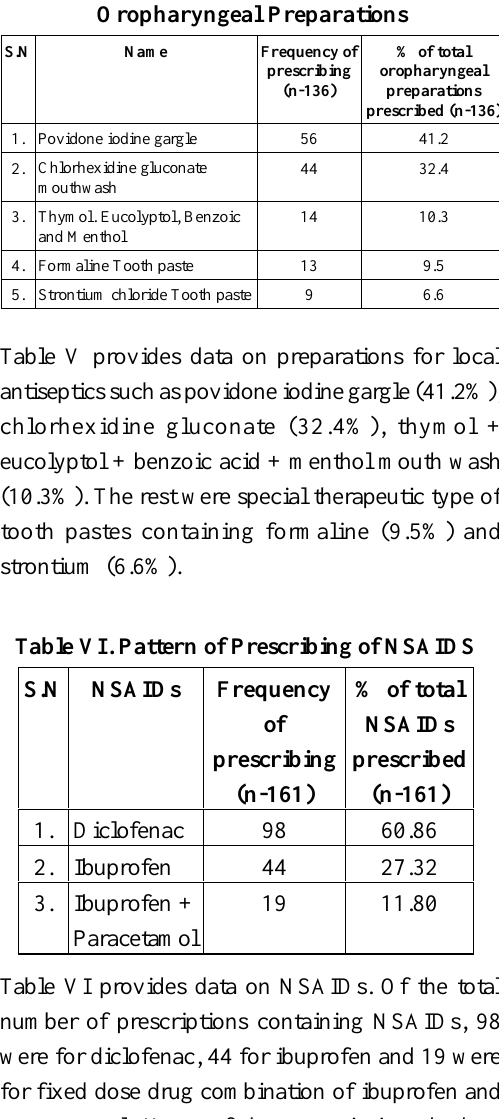
Table V. Pattern of Prescribing of Oropharyngeal Preparations